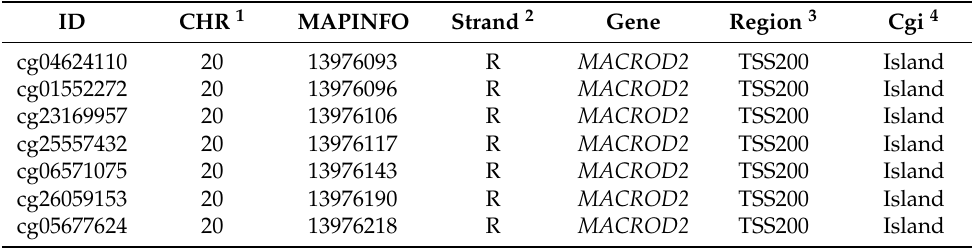
Table 4. Anthropometric and clinical data of the study population for MACROD2 protein quanti fi - cation according to MACROD2 DMR levels in the higher and lower BMI tertiles.